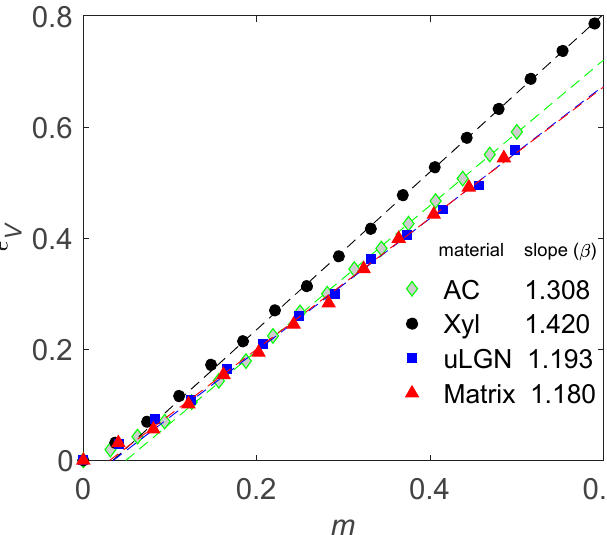
Figure 4. Volumetric swelling strain ( (cid:15) V ) of three polymers and one composite matrix, over the full range of moisture content (m) [106].